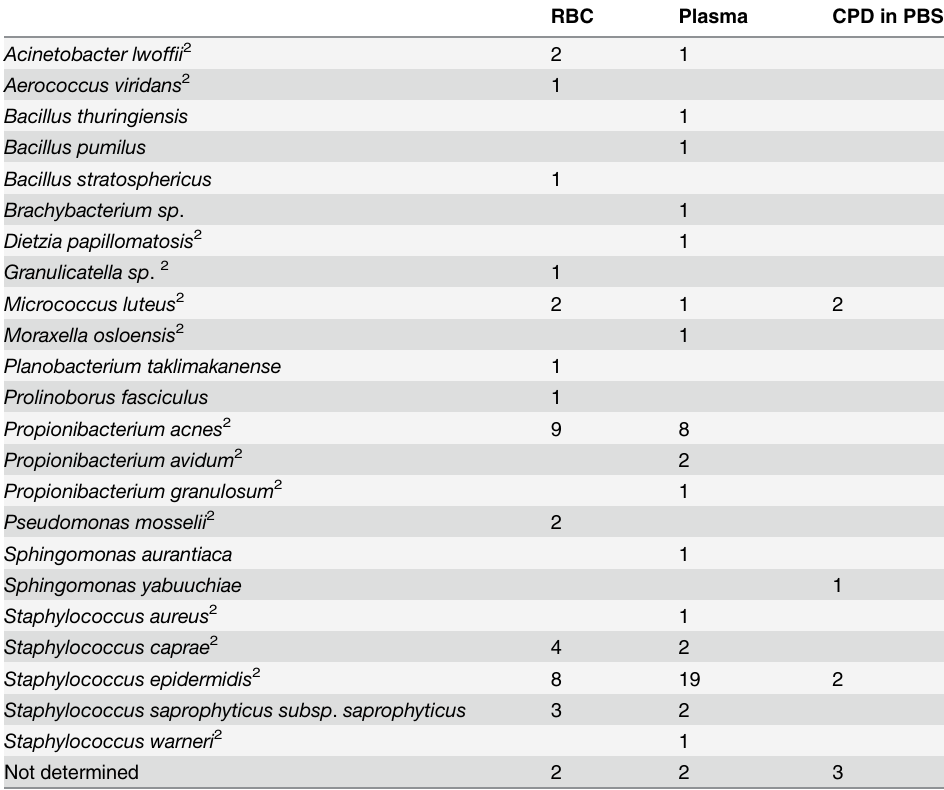
Table 1. Bacterial species identi fi ed 1